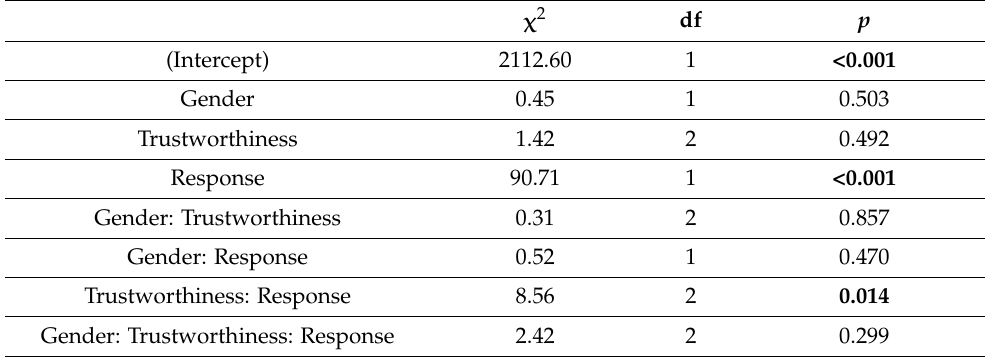
Table 8. Results of Wald χ 2 test for the glmm on response times. df = degree of freedom. Significant p values are reported in